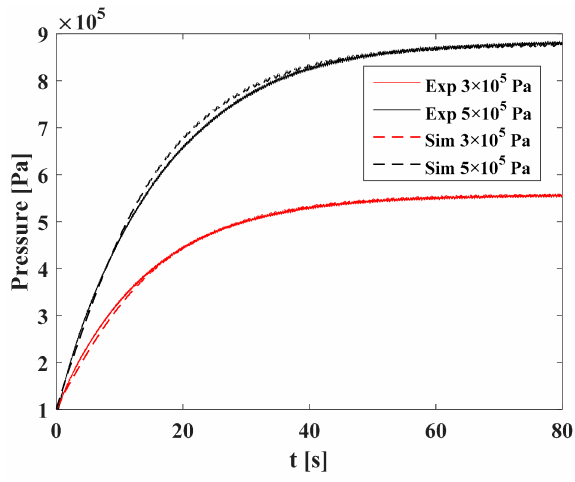
Figure 8. Pressure response in the tank.